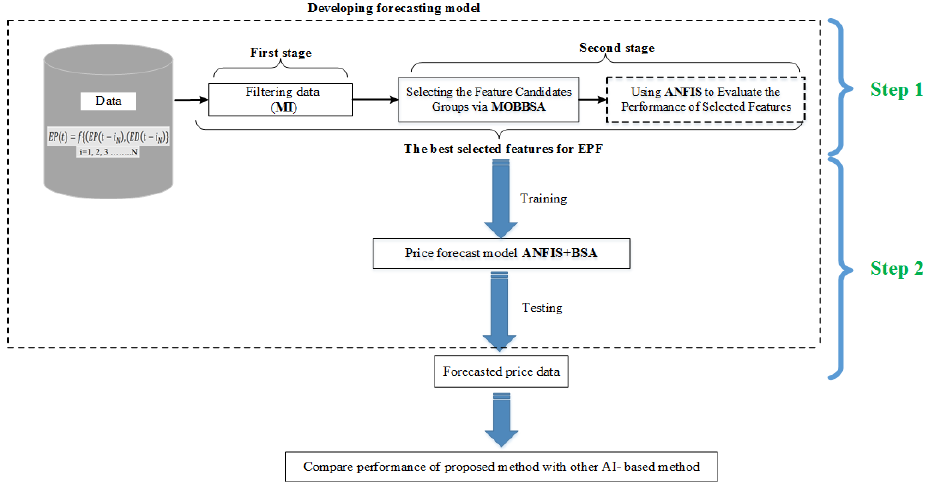
Figure 1. The recent development process for EPF integrated with feature